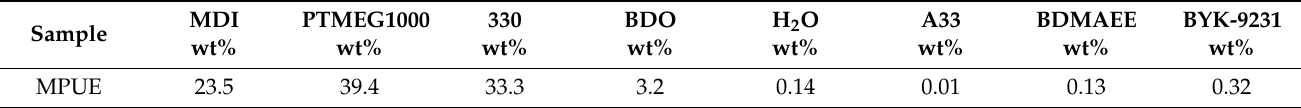
Table 2. The synthetic recipe of the neat MPUE.